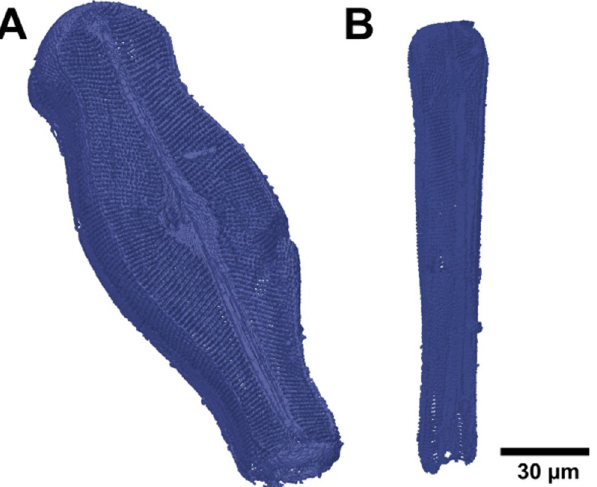
Figure 4. CAD model of D. geminata frustule prepared for 3D printing: ( A ) valve view, ( B ) girdle view.